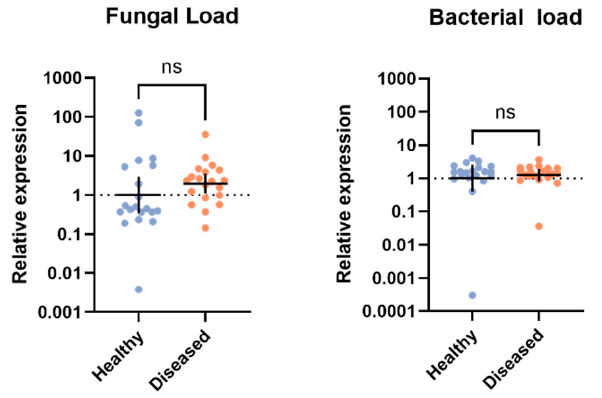
Figure 4. Fungal and bacterial loads via relative quantification of fungal 18s rRNA and bacterial 16s rRNA, respectively, in the whole bodies of Gryllodes sigillatus adults from two populations (sample size: diseased n = 20, healthy n = 20). Each dot represents the microbiocidal load value from a single cricket and the horizontal black bar indicates the mean microbial load with 95% confidence intervals. The statistical significance of fold change values was determined on log 2 -transformed values via unpaired t -test with Welch’s correction; ns = not significant.